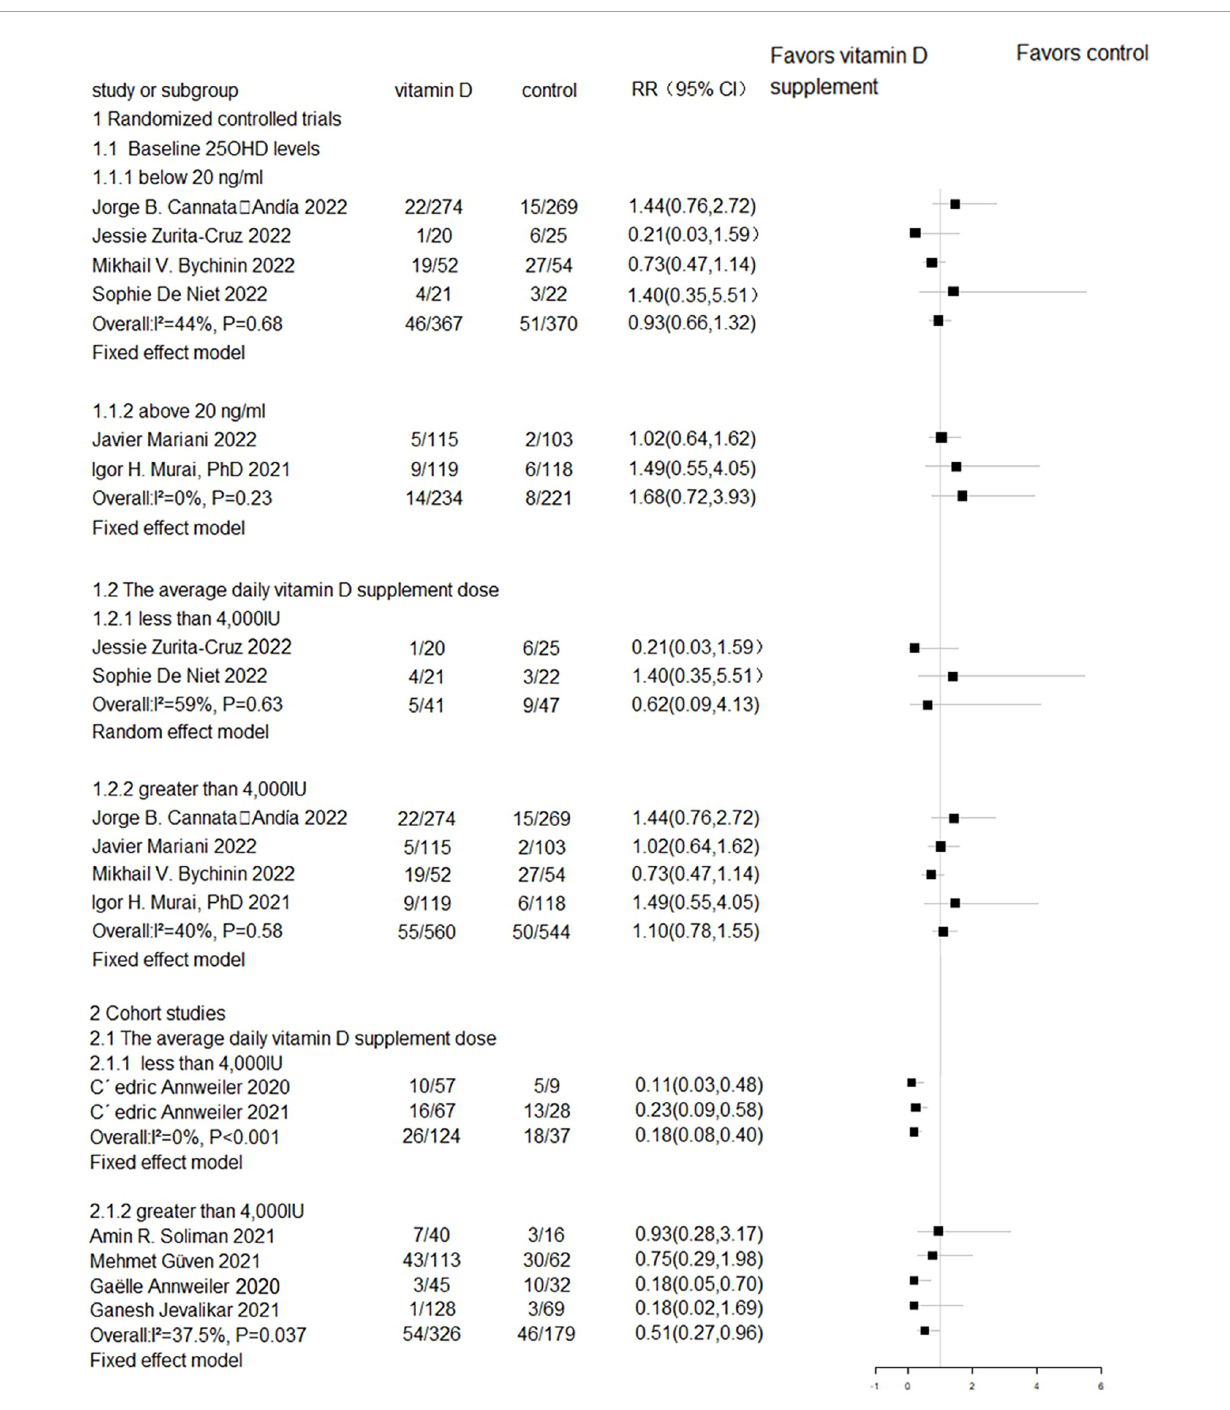
FIGURE5 Subgroup analyses of mortality.